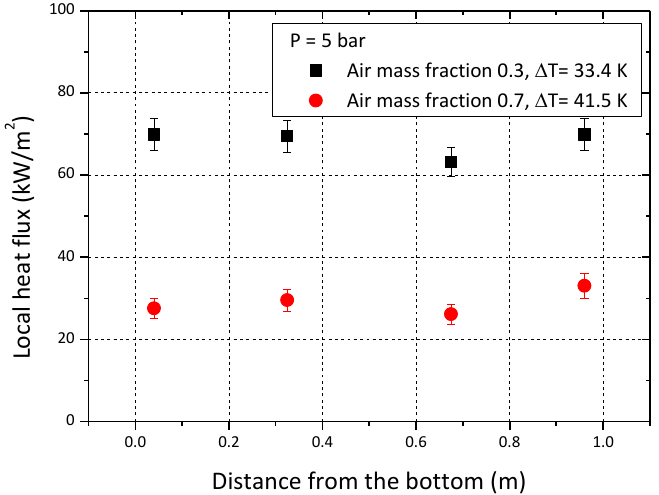
Figure 10. Local heat flux along the tube height when air mass fraction is 0.3 and 0.7 at 5 bar.